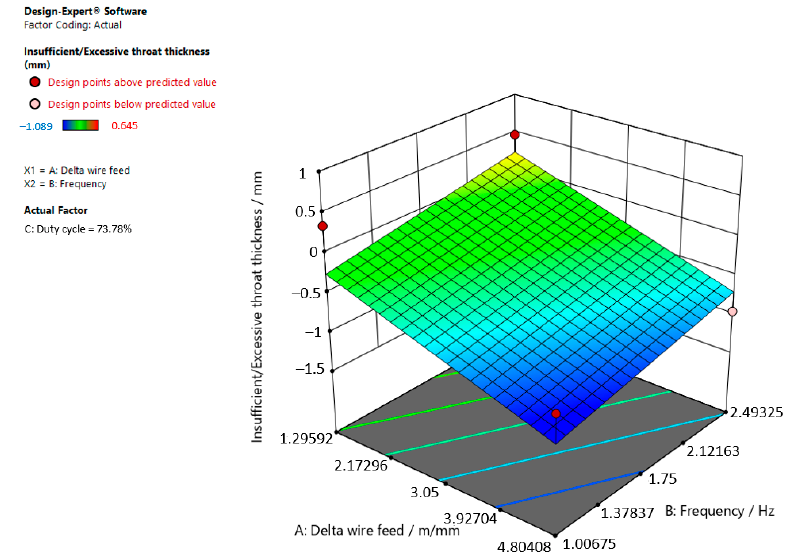
Figure 5. Response surface for the regression model of insufficient/excessive throat thickness at a duty cycle of 73.78%.